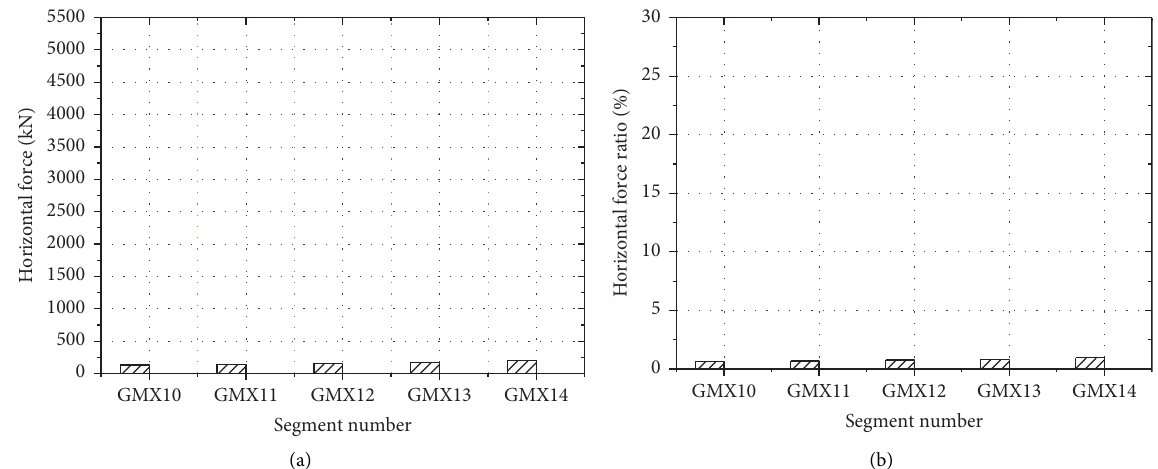
Figure 8: Horizontal force and its proportion borne by the side wall of each segment. (a) Horizontal force. (b) Horizontal force